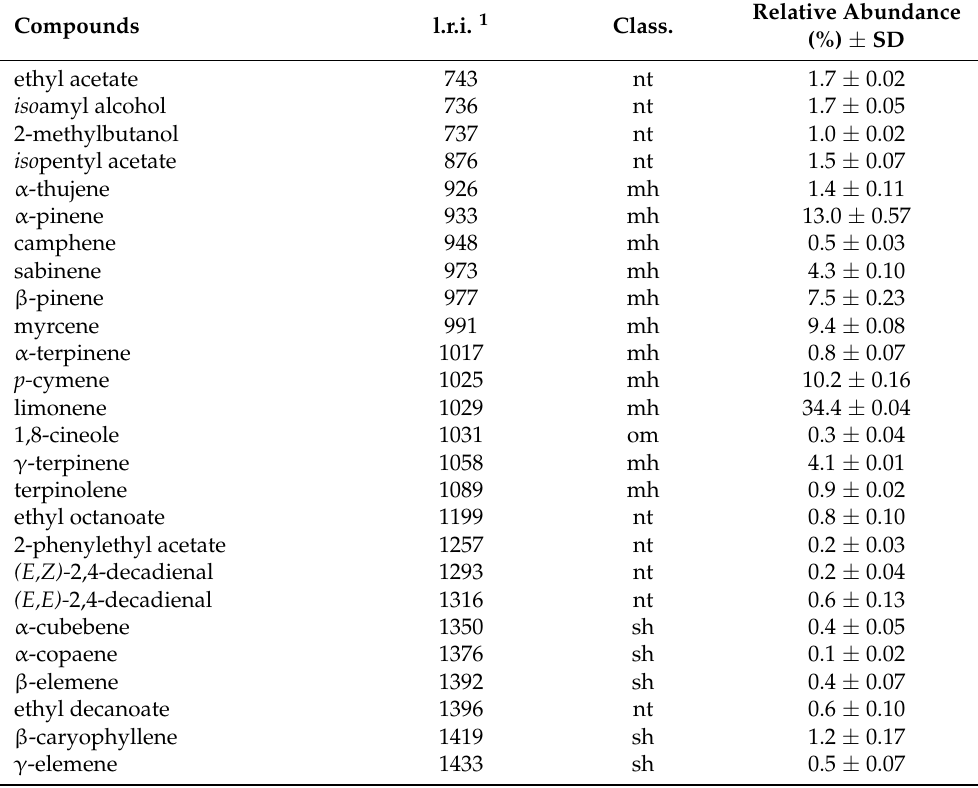
Table 5. Chemical composition of the hibiscus liqueur